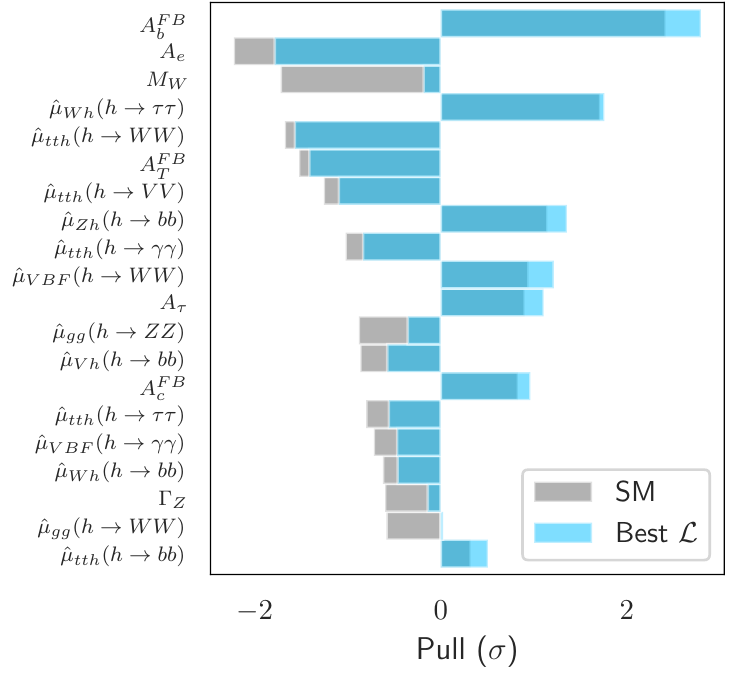
Figure 4 . Pulls for individual observables for the point with best likelihood in our scan, within the region with a strong FOPT. We show the twenty observables deviating the most from the SM